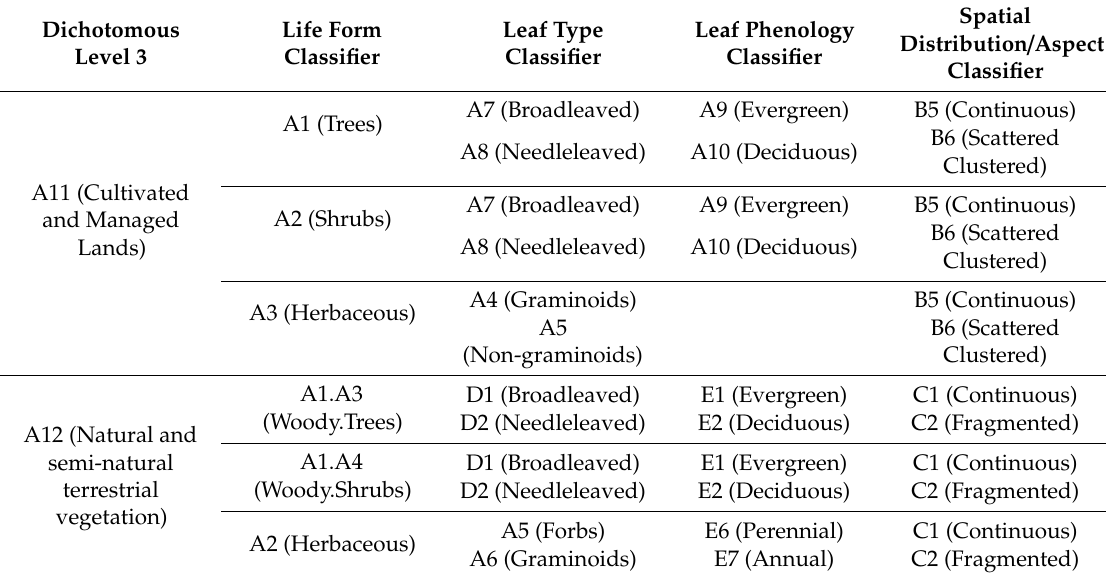
Table 2. List of Land Cover Classification System (LCCS) classifiers used in the classification